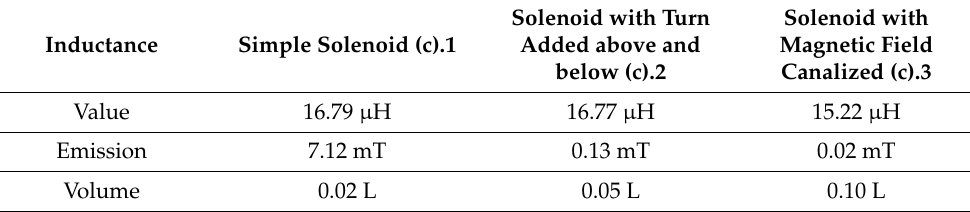
Figure 2. Natural air flux possible in the transformer with induction field canalization in background. Table 1. Inductance result of finite element method